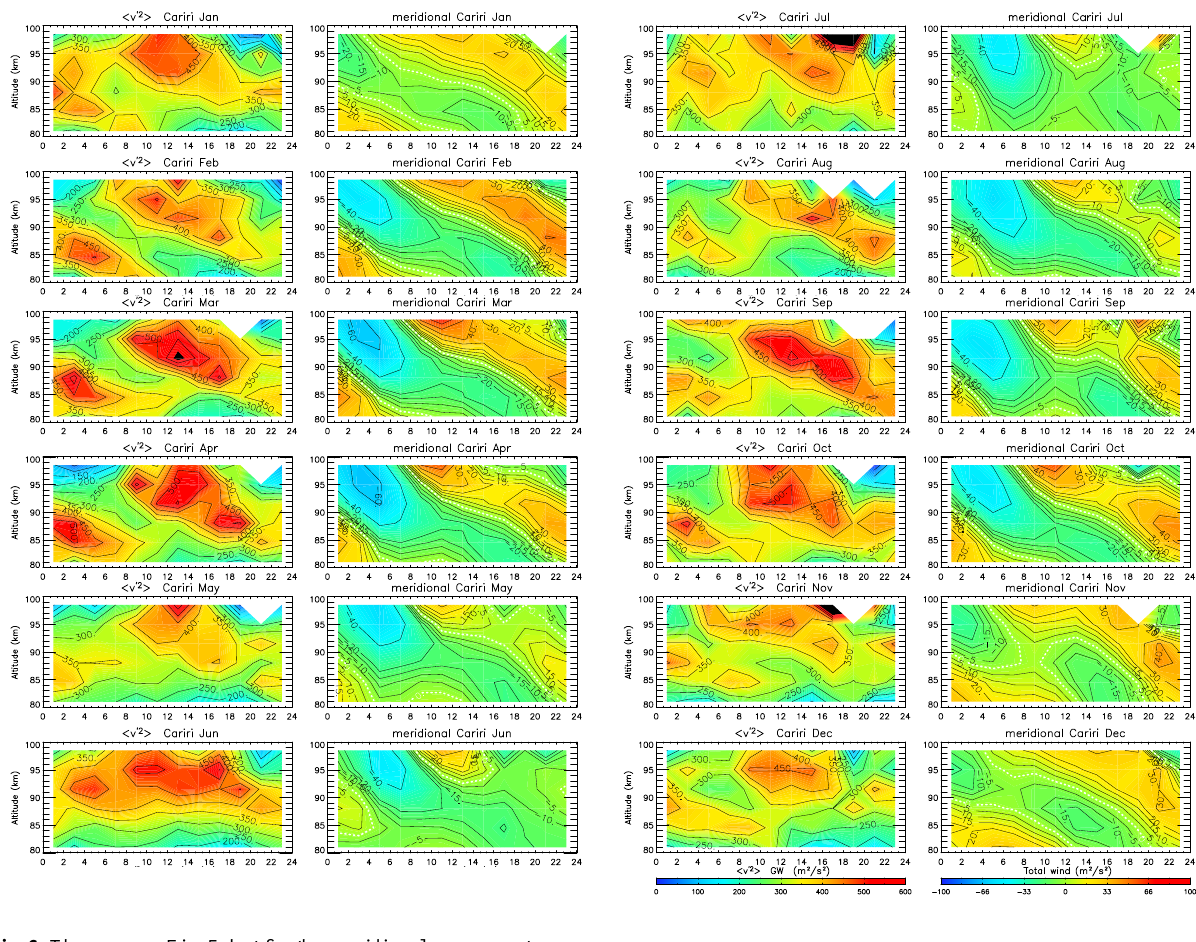
Fig. 6. The same as Fig. 5, but for the meridional